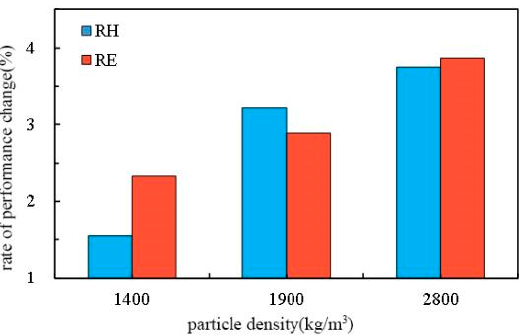
Figure 14. Influence of different particle densities on pump performance.